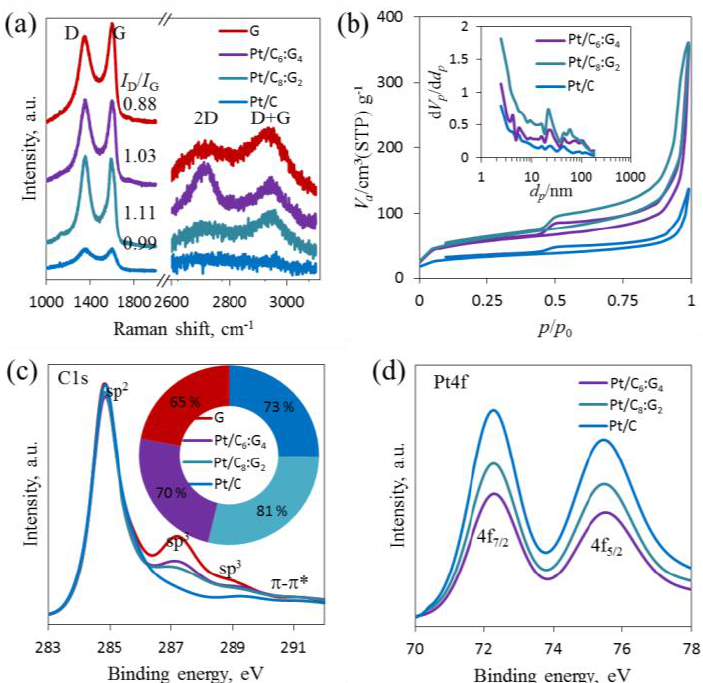
Figure 3. Raman spectroscopy ( a ), nitrogen adsorption−desorption isotherms ( b ), core-level of C 1s ( c ) and Pt 4f XPS spectra for Pt/C, Pt/C 8 :G 2 and Pt/C 6 :G 4 ( d ); for comparison, G-sheets was analyzed by Raman and XPS. Insets: pore size distribution (using BJH method) ( b ) and the sp 2 -C (%) of corresponding samples ( c ).